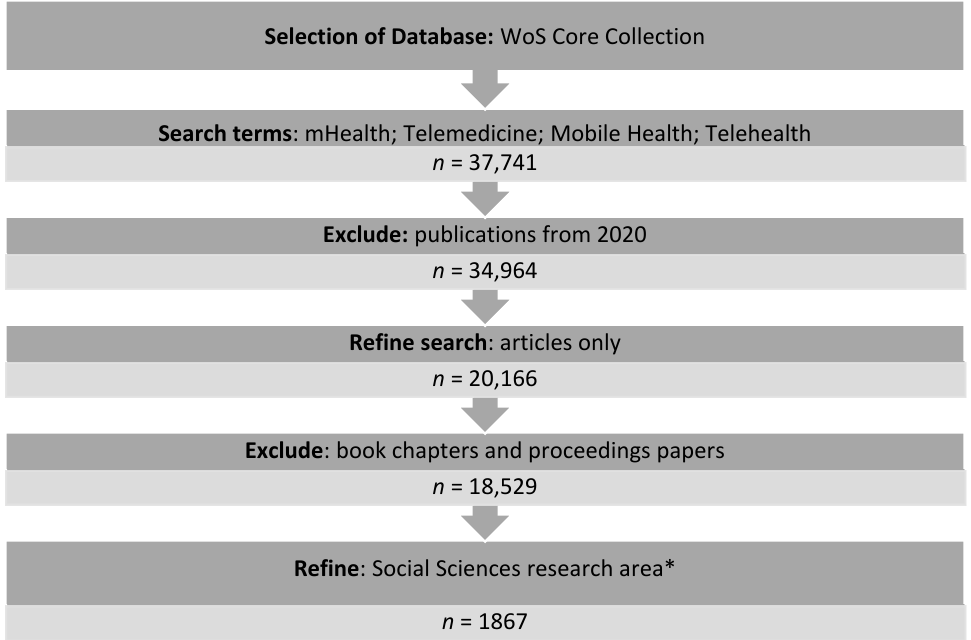
Figure 1. Methodology wtages used in the bibliometric analysis. * Archaeology; Area Studies; Biomedical Social Sciences; Business & Economics; Communication; Criminology & Penology; Cultural Studies; Demography; Development Studies; Education & Educational Research; Ethnic Studies; Family Studies; Geography; Government & Law; International Relations; Linguistics; Mathematical Methods In Social Sciences; Psychology; Public Administration; Social Issues; Social Sciences—Other Topics; Social Work; Sociology; Urban Studies; Women’s Studies.